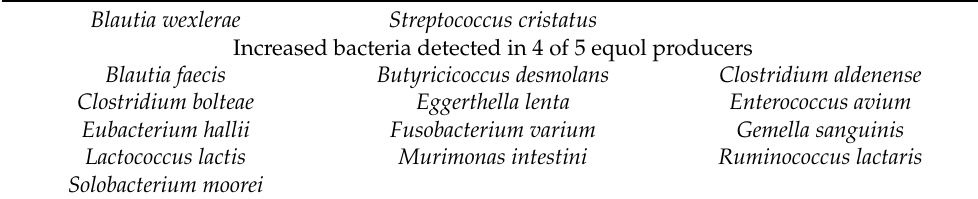
Table 4. List of the increased bacteria detected postintervention in 5 equol